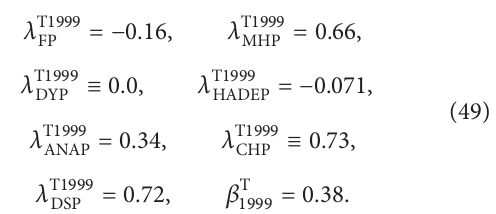
Using DYP as the base party, from Table 3, the 1999 MNL coefficients